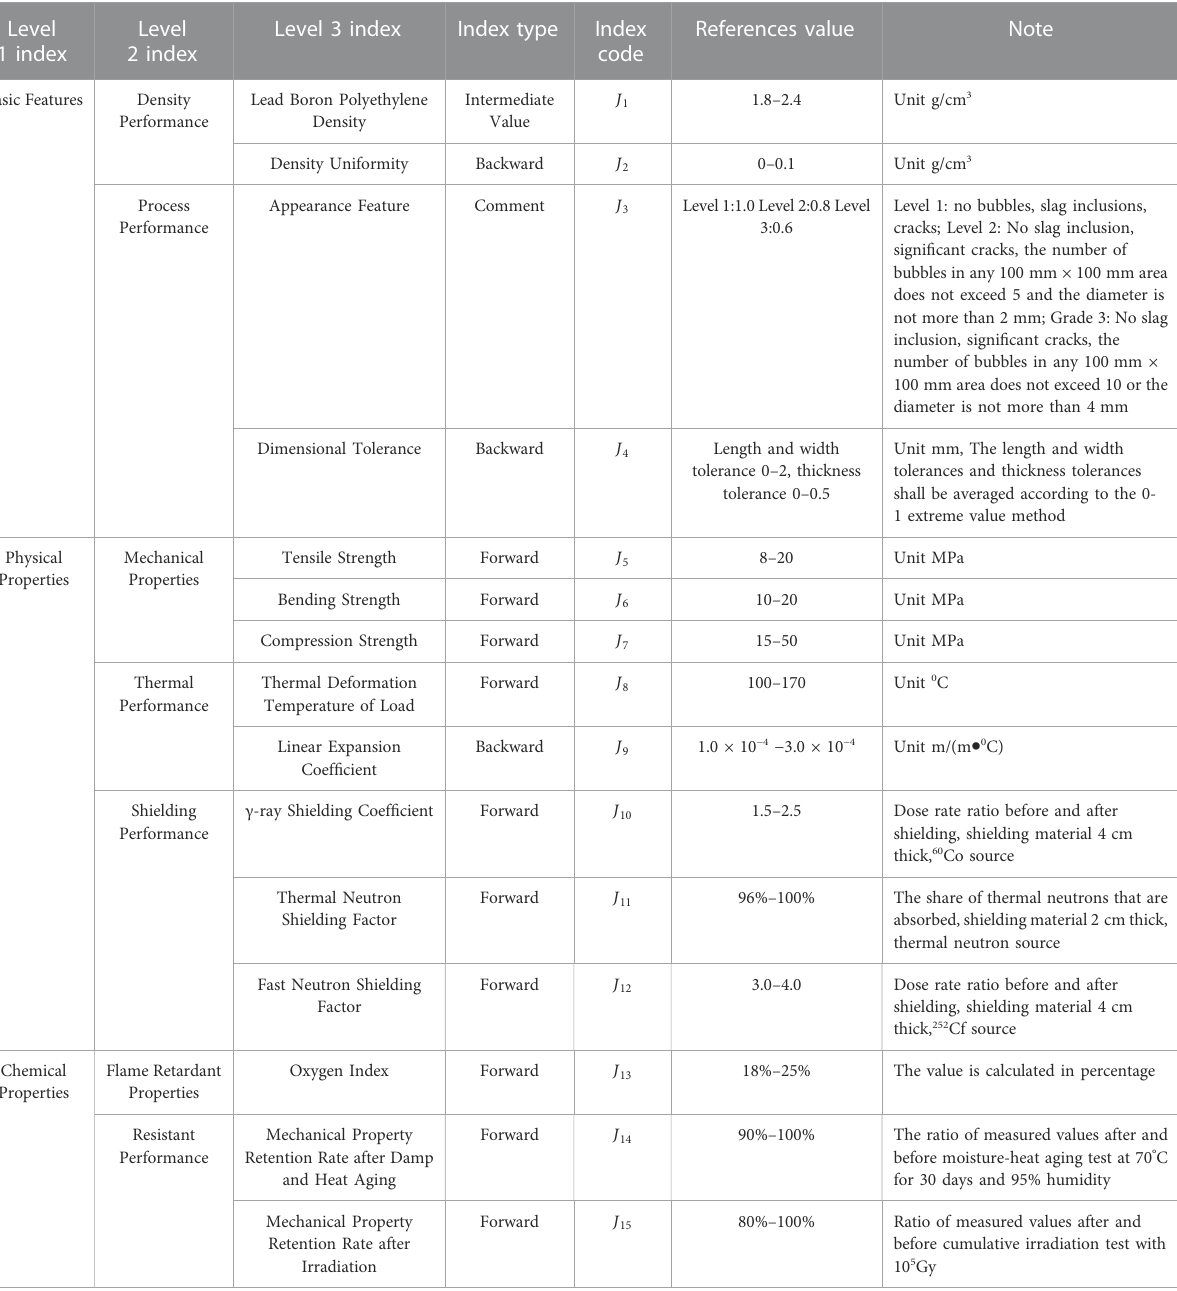
TABLE 2 Performance evaluation index system and numerical reference standard of PB-PE composite shielding